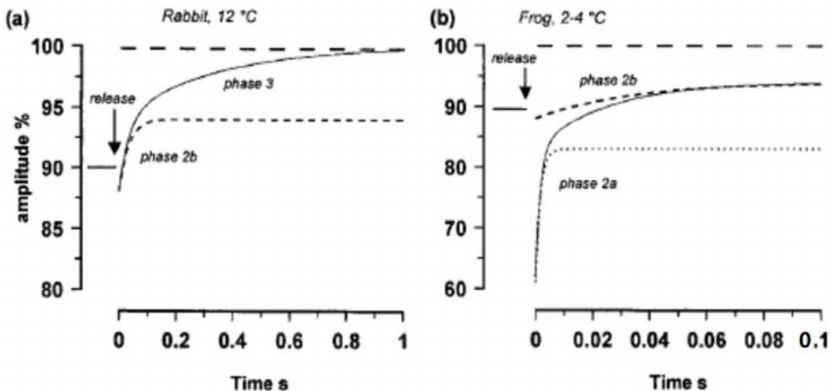
Figure 19. ( a ) The tension transient of a maximally Ca-activated rabbit muscle fibre at 12 ◦ C (as in Fortune et al. 1994). A fibre was maximally Ca-activated at atmospheric pressure, the pressure was then increased to 10 MPa after maximal active tension and tension was depressed to ~90%. The recovery after rapid release occurred in two phases (Phase 2 at ~30/s and Phase 3 at ~3/s). The initial tension drop (Phase 1) was small (<5%). Phase 2 (dashed curve) was sensitive to inorganic phosphate and was identified as crossbridge force generation (see Fortune et al., 1991, [22]) and Phase 3 was identified as the rate-limiting step in crossbridge cycle (adapted from Vawda et al., 1999, [20]). ( b ) The tension is transient from frog muscle fibre at 2–4 ◦ C (Vawda et al., 1999, [20]) (the pressure was increased to 10 MPa when the fibre was relaxed, the fibre was activated by electrical, tetanic, stimulation and released during the tension plateau). In comparison with the tension of an atmospheric contraction, the tension at 10 MPa was lower, ~90%, (see Figure 3a) and the tension recovery after pressure release was incomplete within the duration of the tetanic tension plateau (<200 ms). The transient has two recovery phases (Phase 2a, ~500/s and Phase 2b ~40/s) and the initial tension drop upon pressure release is 30%. The Phase 2a does not contribute to tension rise above the pre-release level (dotted curve). The short dashed curve is Phase 2b in the rabbit